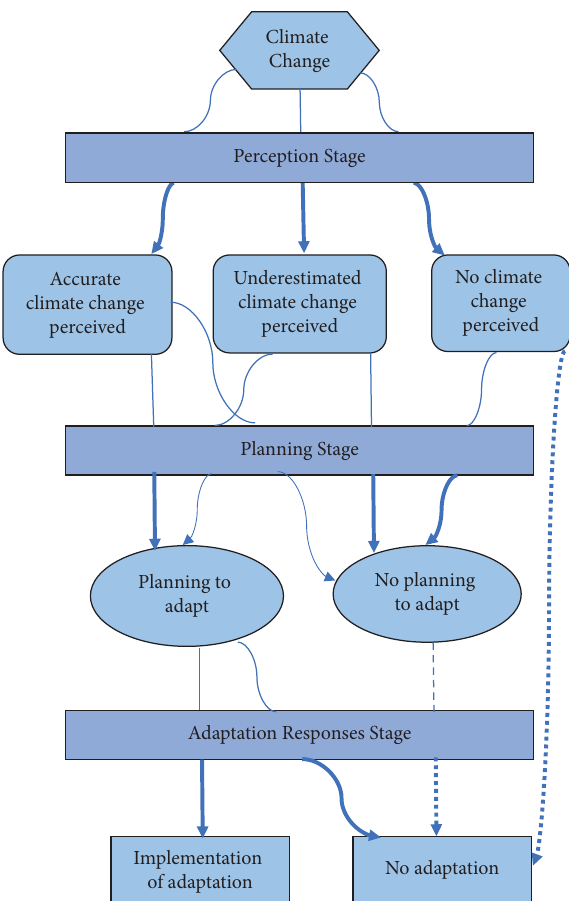
Figure 1: Conceptual framework of adaptation response